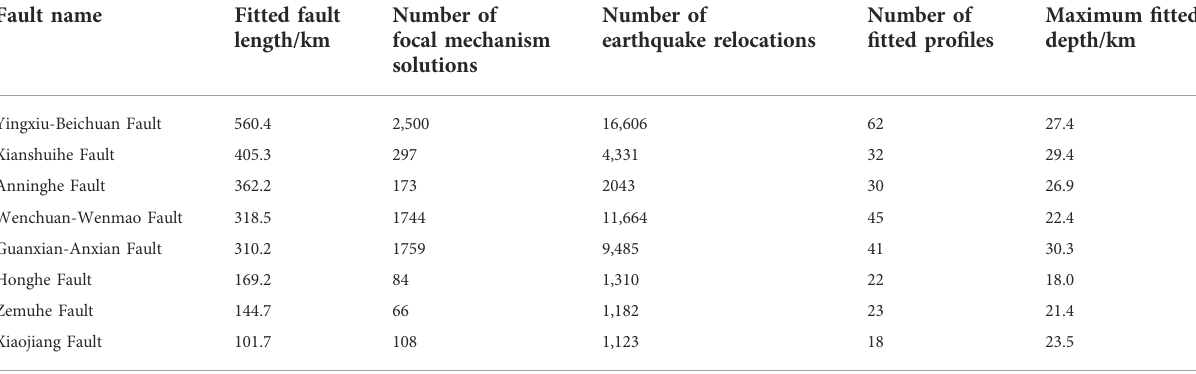
TABLE 2 Geometry modeling parameters for the main